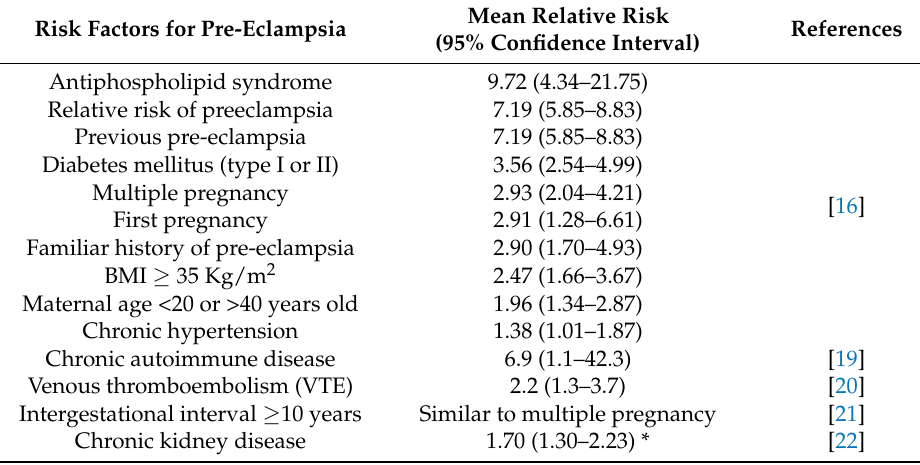
Table 2. Summary of risk factors for